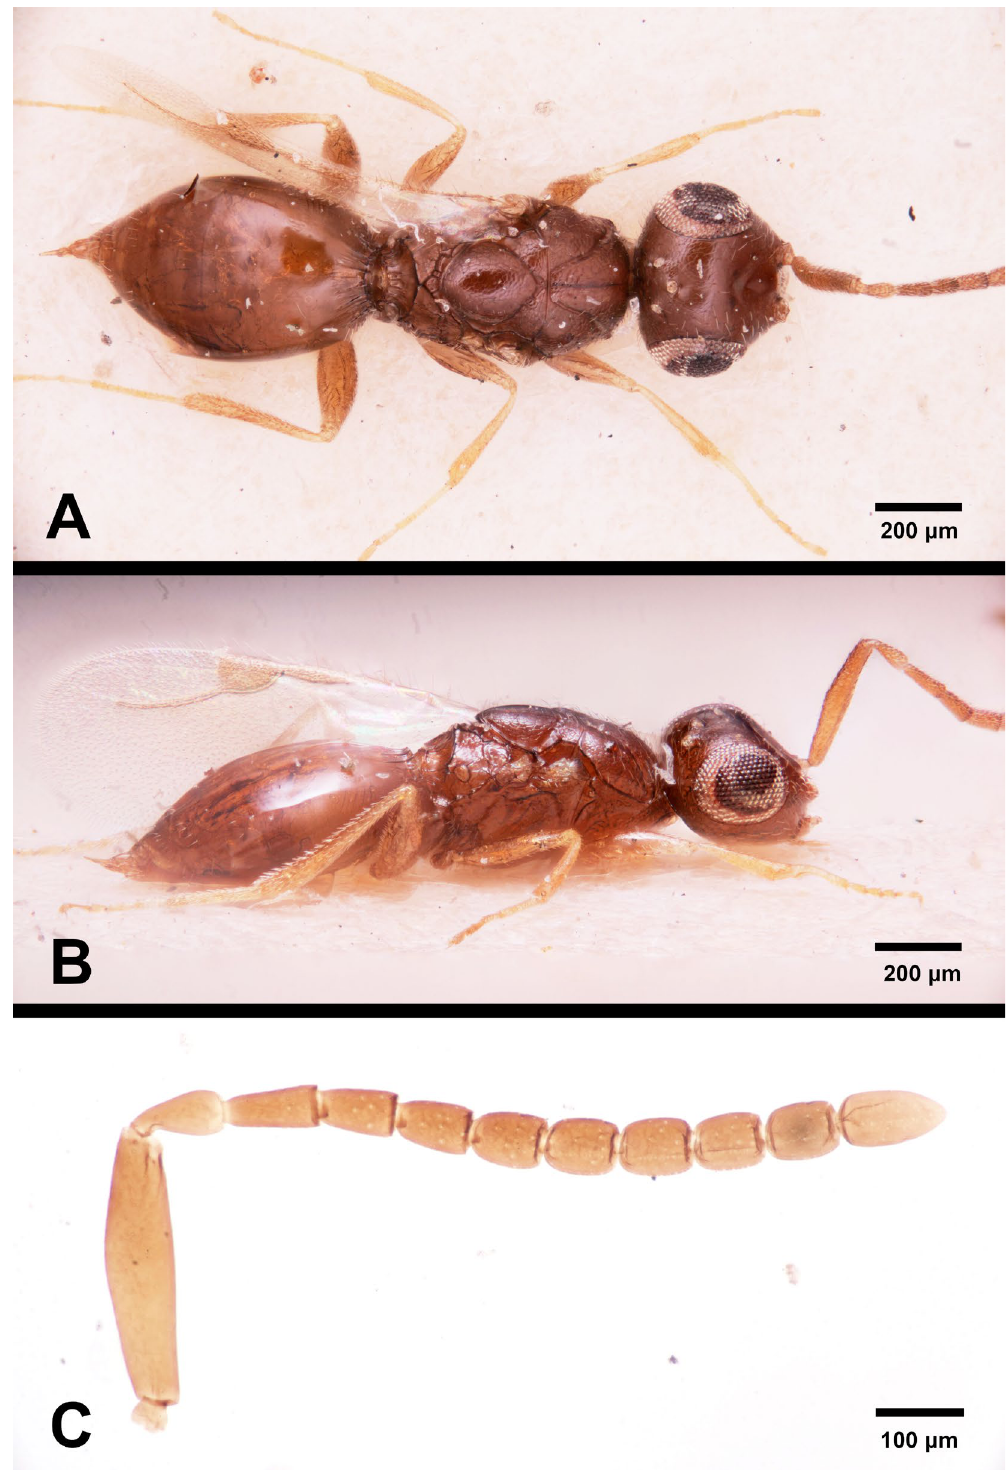
Fig. 23. Dendrocerus omostenus Dessart, 1979, holotype, ♀. A . Dorsal habitus (MNhN EY25348). B . Lateral habitus. C . right antenna (MNhN